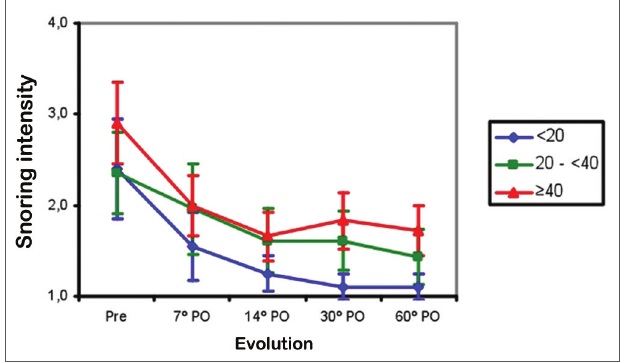
Figure 5. Mean snoring score in three age groups (years) in the pre- operative (Pre) and postoperative (PO) periods.